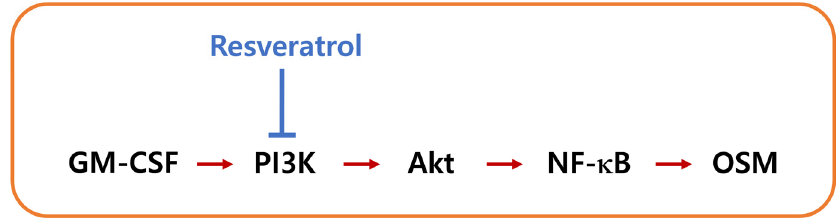
Figure 7. A schematic diagram of the proposed inhibition of OSM by RES. Supplementary Materials: The following are available online at https://www.mdpi.com/article/10.3390/cimb44020037/s1. Figure S1: Effects of RES on the production and mRNA expression of OSM in neutrophil-like dHL-60 cells. Figure S2: Effects of RES on the phosphorylation of PI3K, Akt, and NF- κ B in neutrophil-like dHL-60